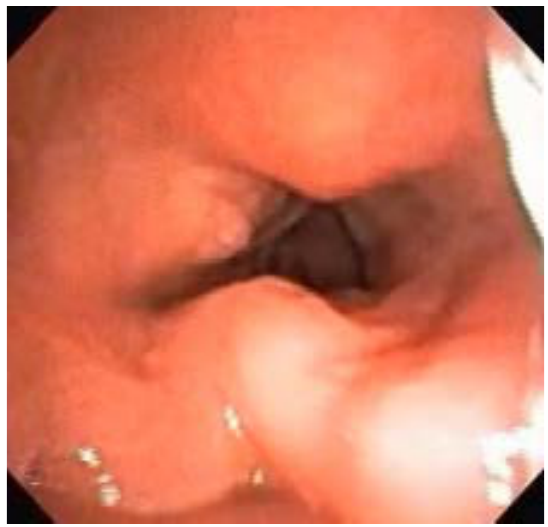
Figure 3. MPS I patient with significant supraglottic involvement (infiltration of false vocal fold, posterior larynx, and epiglottis).